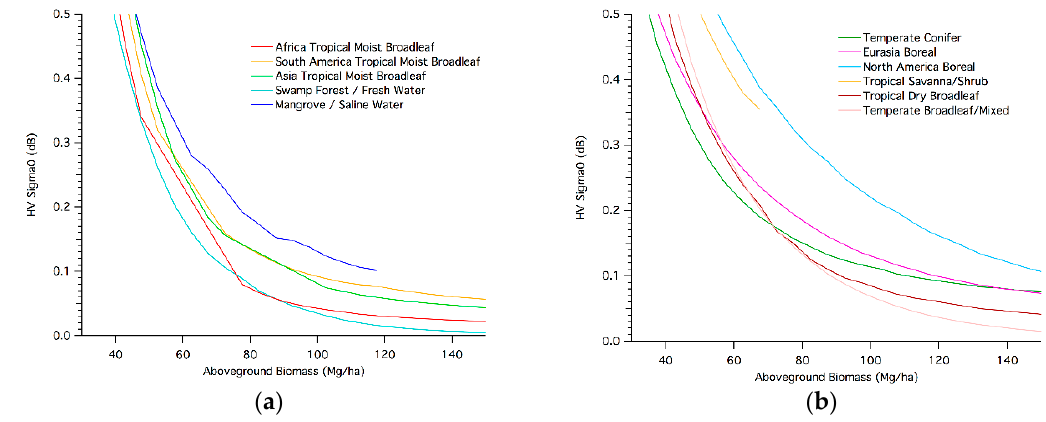
Figure 5. Radar sensitivity required to detect a 20 Mg·ha − 1 change in AGB. The sensitivity requirement is calculated using Equations (3) and (4). The values for each bin are calculated using the derivatives from Equations (3) and (4) at the middle AGB value for each bin and ±10 Mg·ha − 1 from that middle AGB value. A total of 10 forest types are distinguished here, for better visibility, they are plotted in two separate figures: ( a ) Africa tropical moist broadleaf, South America tropical moist broadleaf, Asia tropical moist broadleaf, swamp forest/fresh water, mangrove/saline water; ( b ) temperate conifer, Eurasia boreal, North America boreal, tropical savanna/shrub, and tropical dry broadleaf.